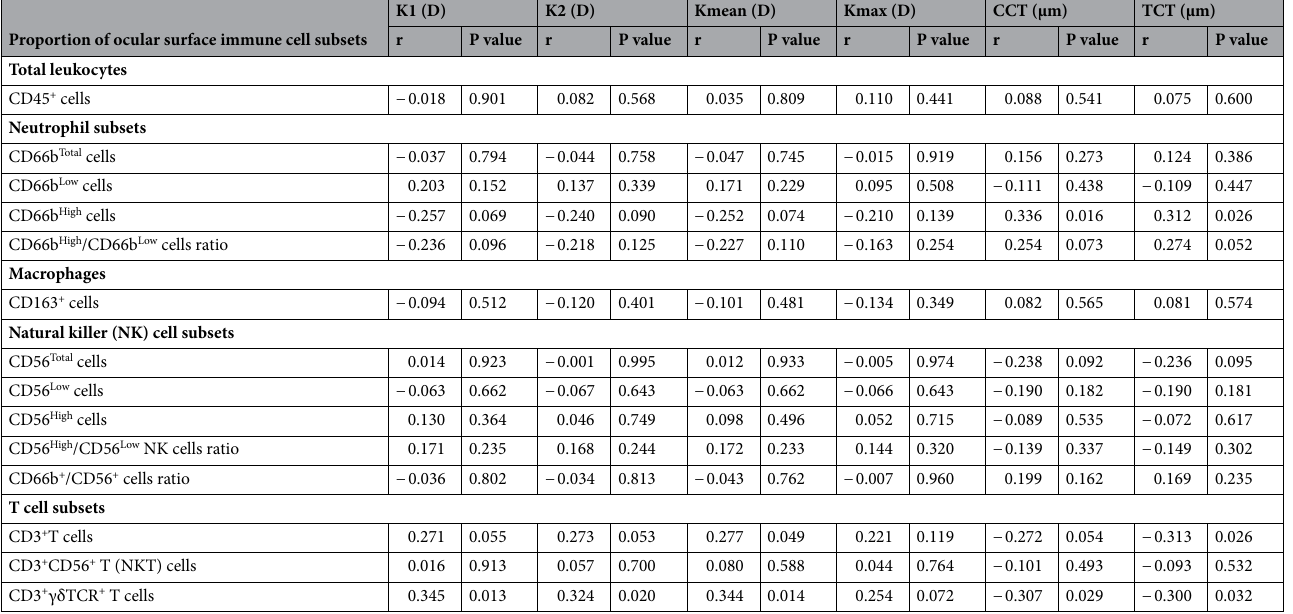
Table 2. Association of ocular surface immune cell subset proportions with corneal keratometry and pachymetry indices of KC patients. r = Spearman rank correlation coefficient.